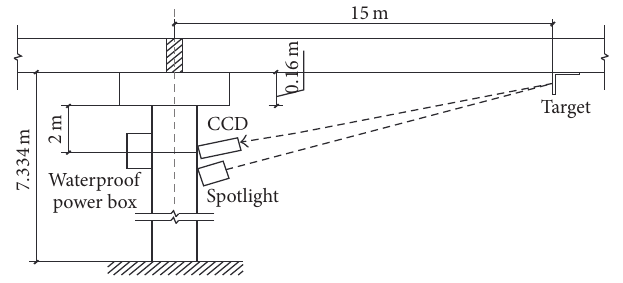
Figure 8: Installation location of CCD along longitudinal direction.